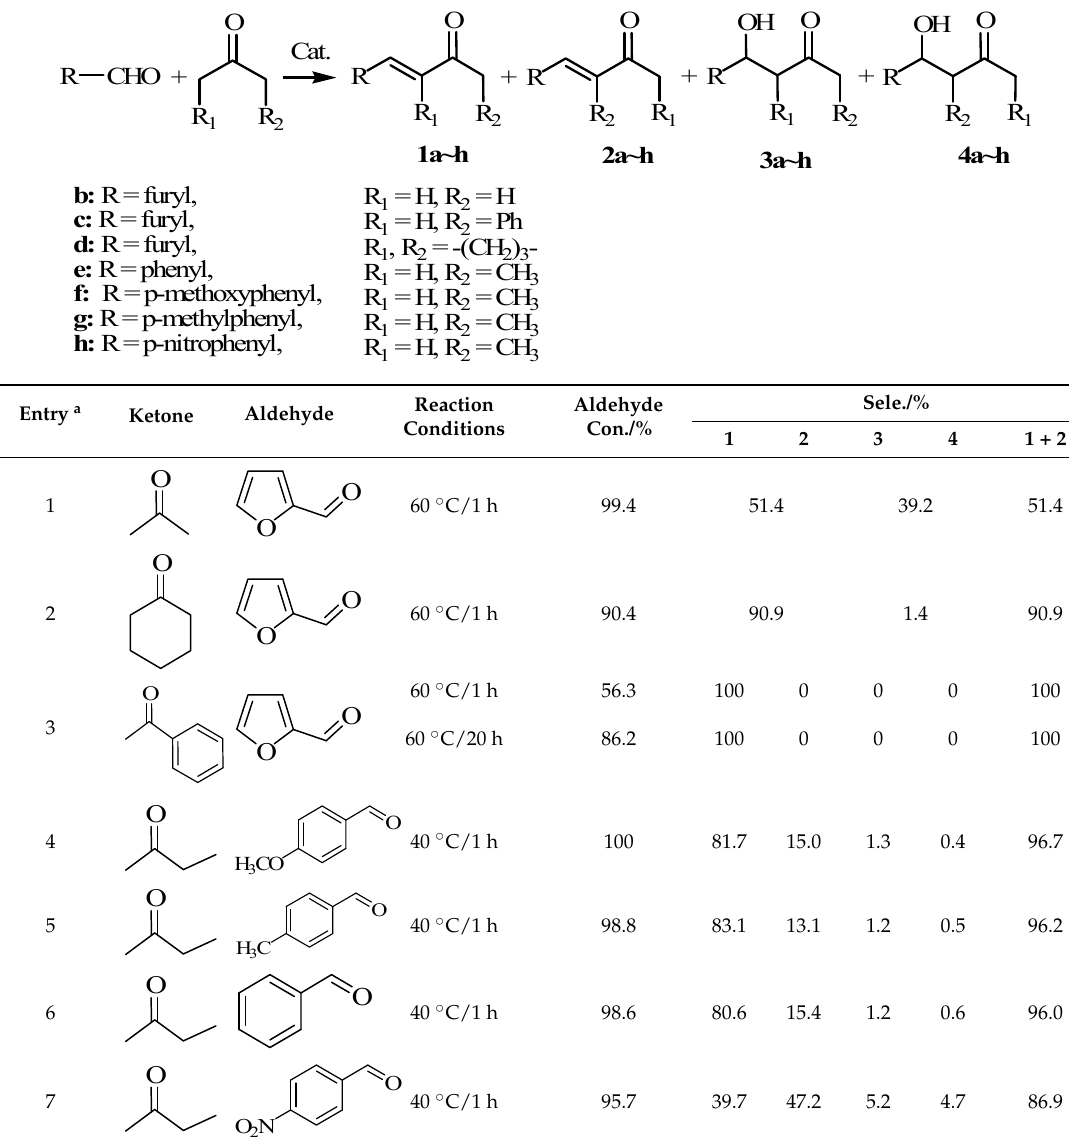
Table 3. Aldol condensation of aromatic/heterocyclic aldehydes with ketones catalyzed by 3-pyrrolidinamine.